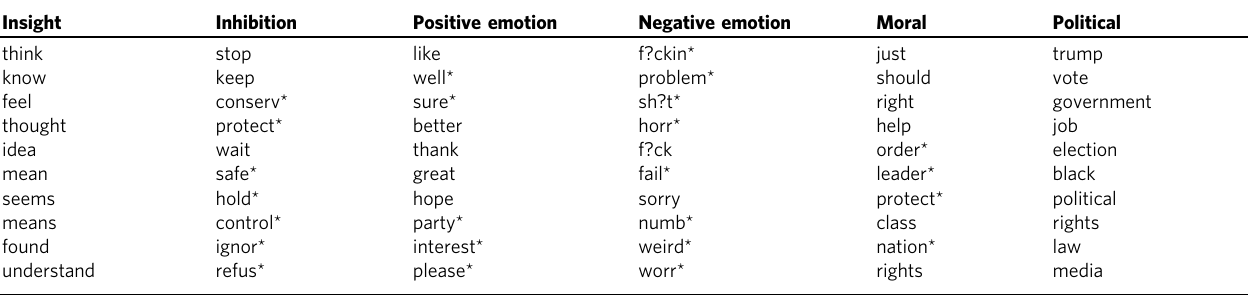
Table 4 Distinctive usage of words by users who scored high versus low on the